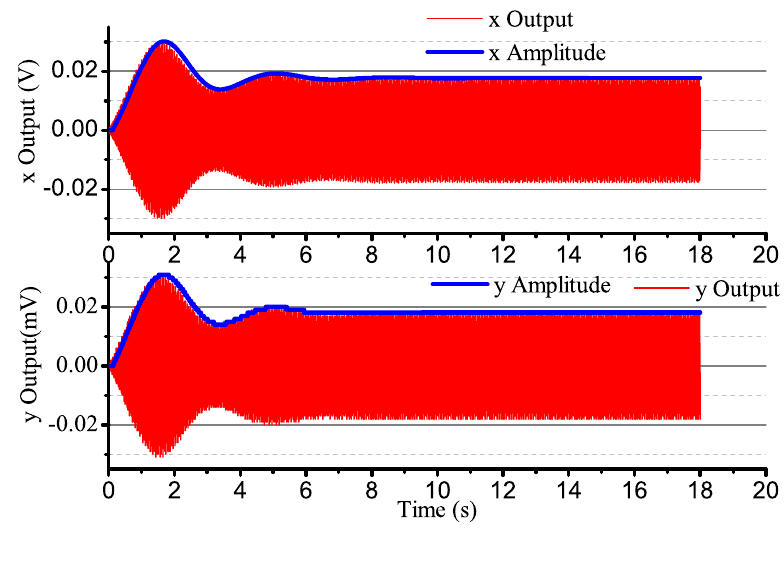
Figure 17. The gyro’s output with control in Ω = 0 .